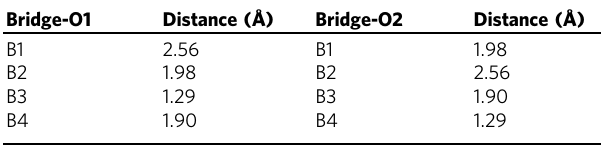
The distances differ because of the rotated and tilted RuO 6 octahedra (see Figs. 1 and